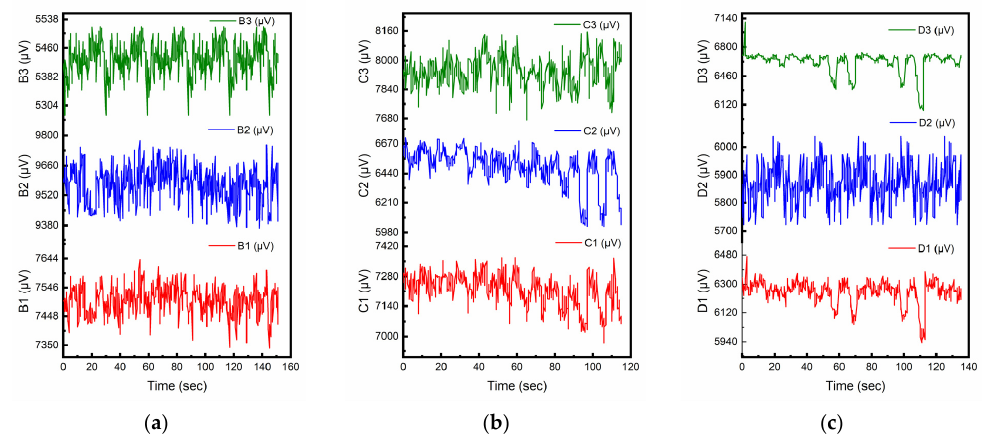
Figure 4. Piezoelectric responses for direct mixing method with different W/C ratios. ( a ) W/C = 0.6 (Cement:Sand = 1:2). ( b ) W/C = 0.5 (Cement:Sand = 1:2). ( c ) W/C = 0.4 (Cement:Sand = 1:2).